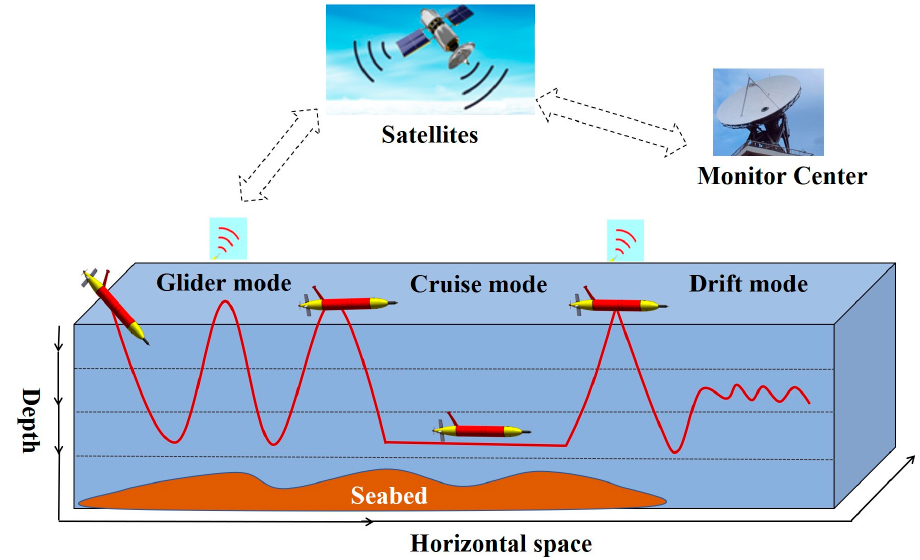
Figure 2. Typical working modes of the long-range hybrid AUV are: the glider mode, the cruise mode, and the drift mode. The long-range hybrid AUV combines the attributes of AUV and buoyancy-driven glider and has excellent maneuverability.